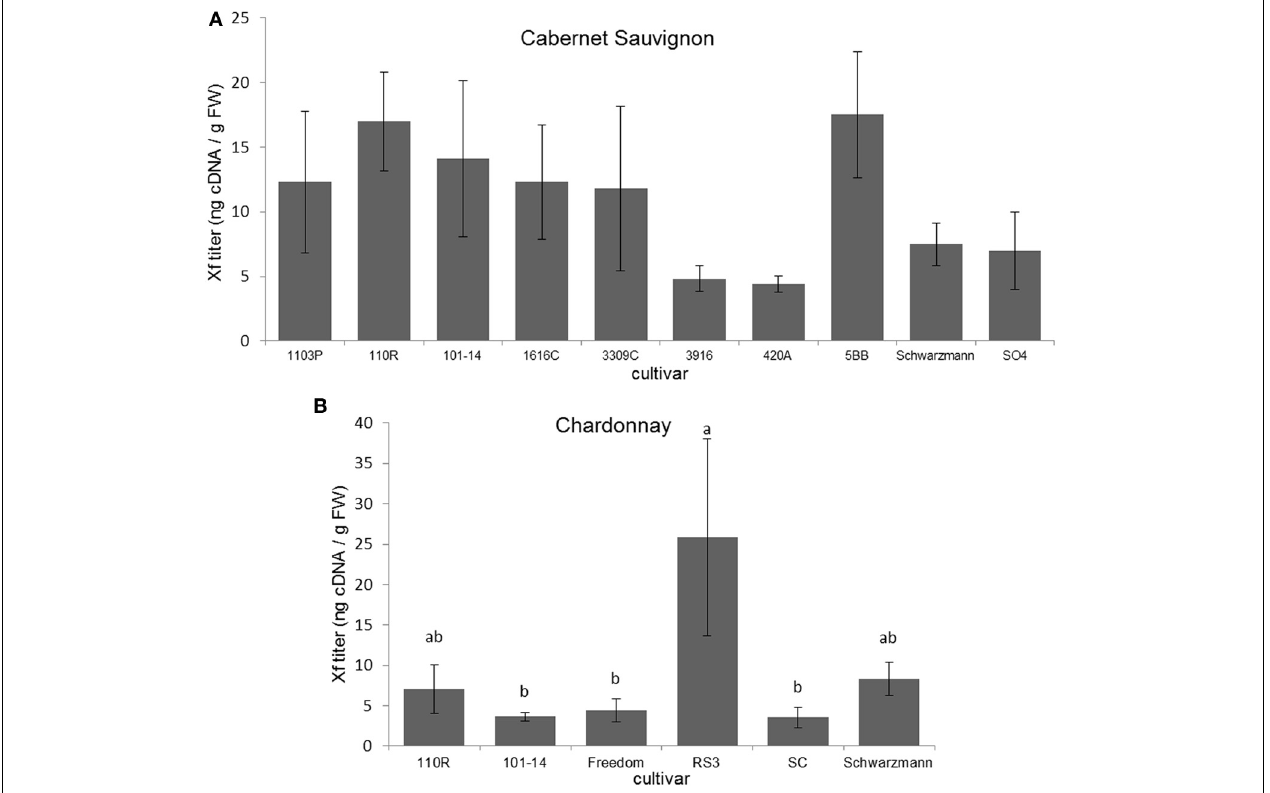
FIGURE 2 | Xf titer found present in (A) Cabernet Sauvignon or (B) Chardonnay scion on various rootstock cultivars. Letters represent differences pairwise by LSD tests. Bars indicate SE. See text for full descriptions of